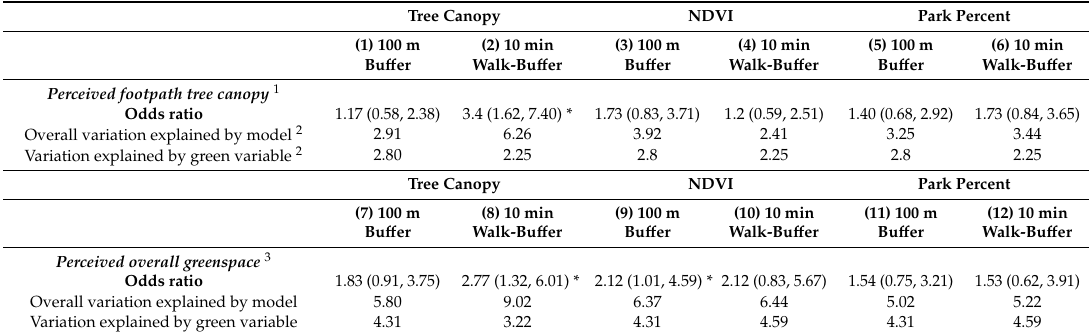
Table 2. Odds of agreeing or strongly agreeing with statements about perceived greenspace as a function of objective greenspace variables, with 95% confidence intervals in brackets. Odds ratios associated with the objective greenspace-related variable are shown from 12 models. The odds ratios associated with other covariates in these models are not